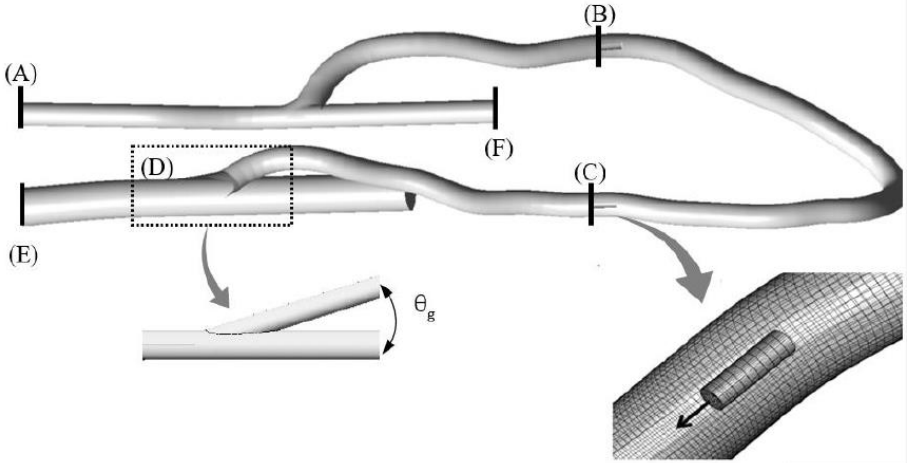
Figure 3. Geometry and boundary conditions of AVG. Artery inlet; Hematocrit: 34% ( A ), Suction needle ( B ), Injection needle; Hematocrit: 34%, 45%, 58% ( C ), Anastomosis angle; 15°, 30°, 45° ( D ), Venin outlet ( E ), Artery outlet ( F ).